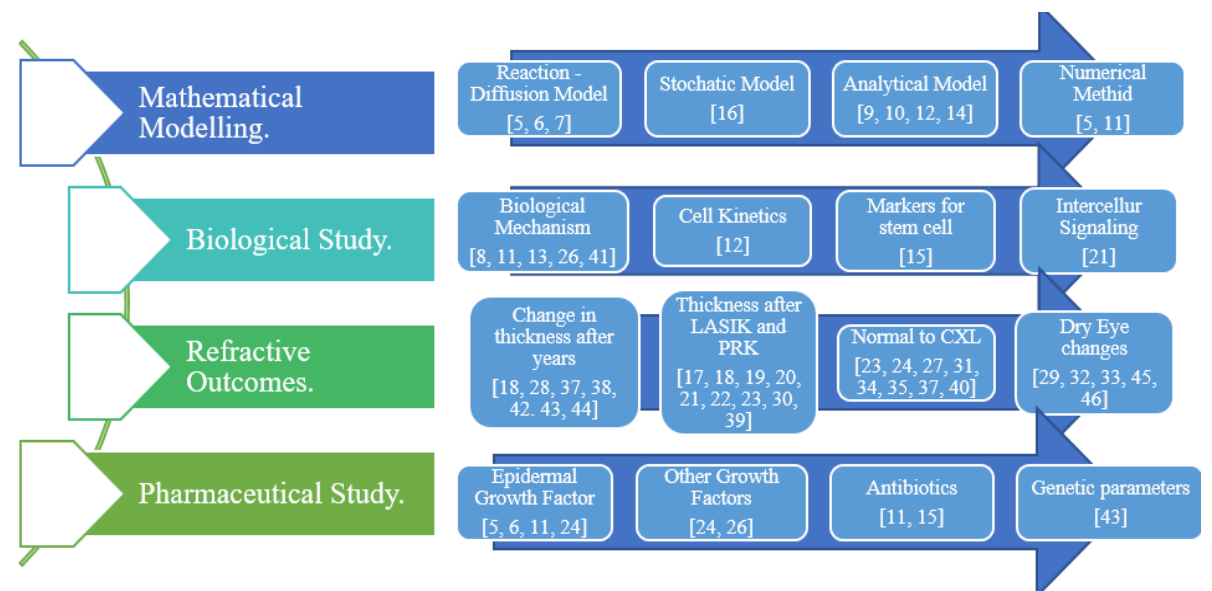
Four imperative disciplines (as shown above) were reflecting the interest of the researchers in studying the corneal re-epithelization